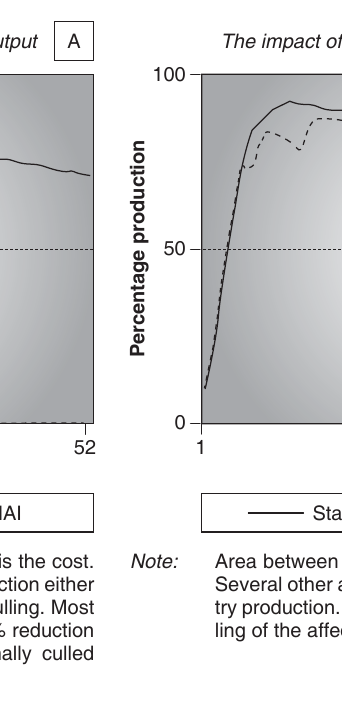
FIG. 2 Graphs A and B showing evaluation of cost of animal diseases